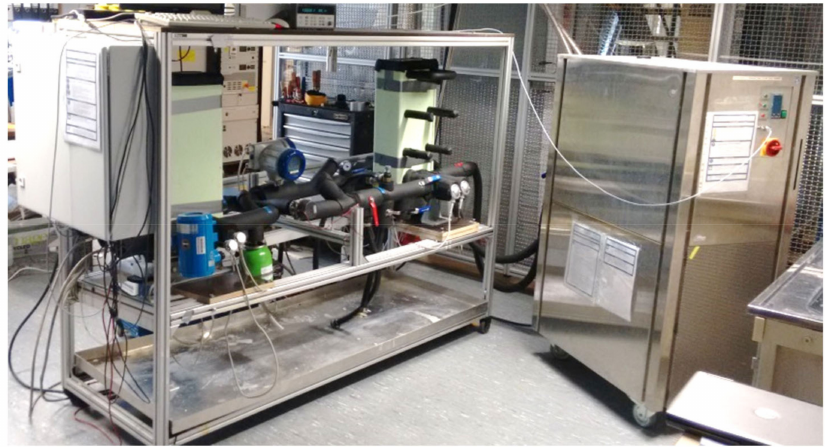
Figure 27. Picture of stability testing device “ISE